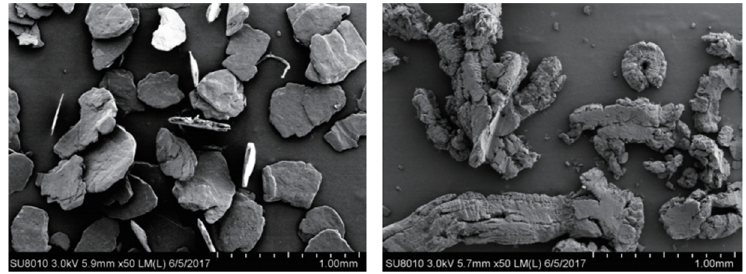
Figure 21. SEM images of flake graphite ( left ) and expanded graphite ( right ) [71] .